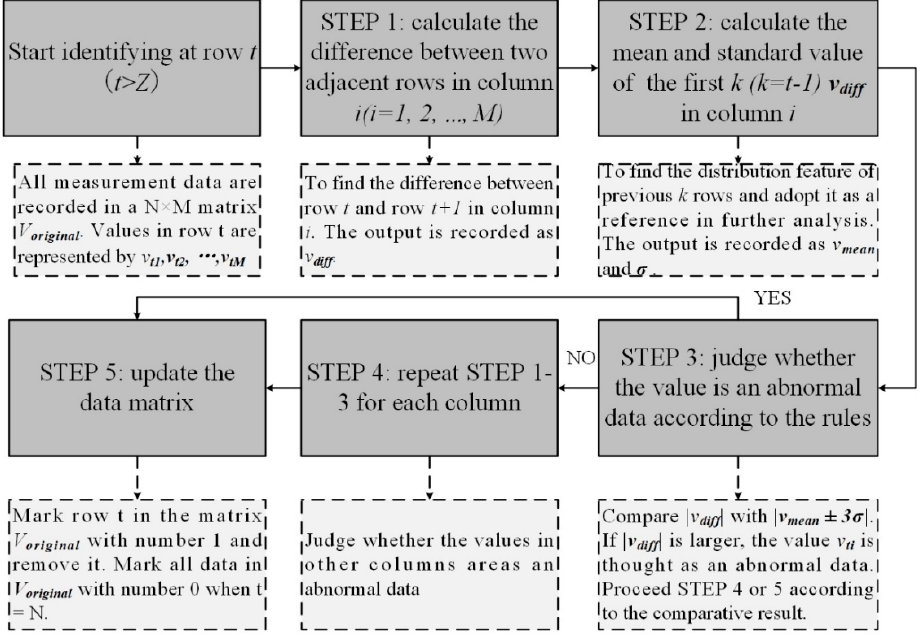
Figure 2. Data identifying algorithm.